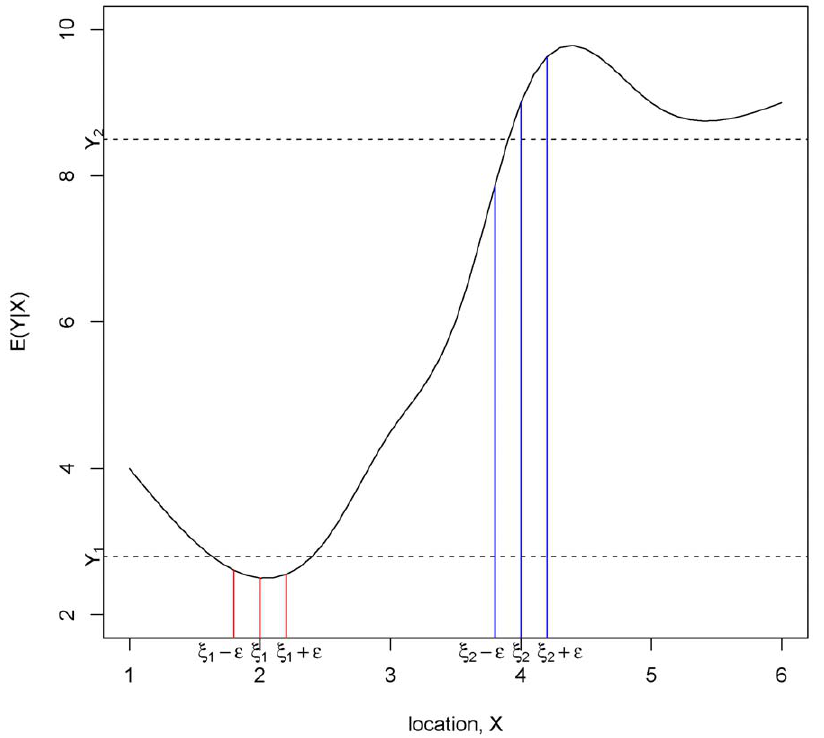
Figure 2. A diagrammatic representation of the problem where the curve corresponds to E ( Y t D X t , Y ƒ t { 1 ) . j 1 is a point with small local slope (in this case, the precision of the location is less influential) and j 2 is a point with a larger local slope (here, the precise location is influential).